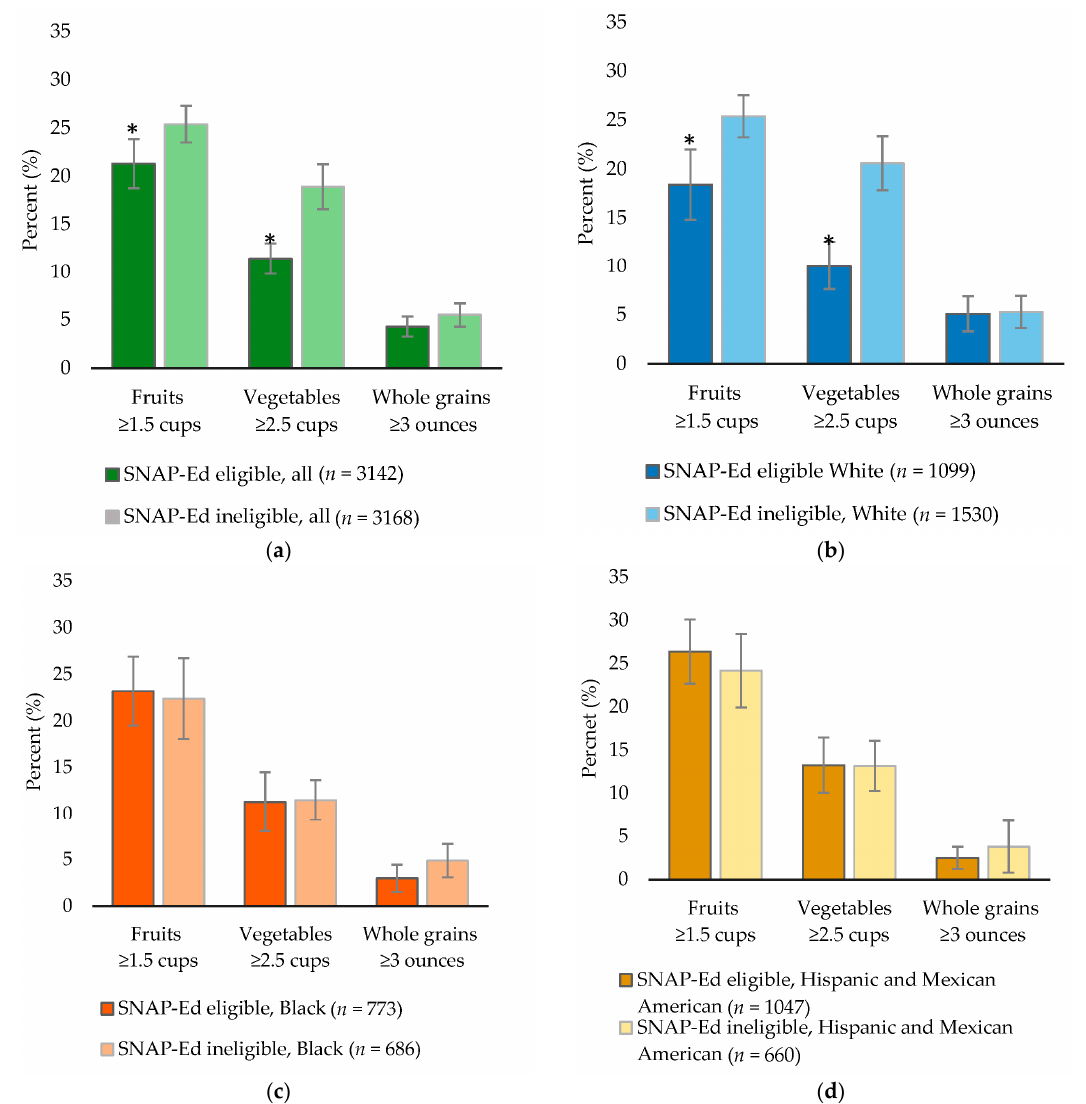
Figure 1. The percentage meeting the Dietary Guidelines for American recommendations of SNAP-Ed eligible and SNAP-Ed ineligible women nationwide, NHANES 2007–2012. ( a ) All ( b ) White ( c ) Black ( d ) Hispanic/Mexican American. Fruit and vegetable intakes are measured in cup equivalents and whole grain intake is measured in ounce equivalents. * Significantly different between SNAP-Ed eligible and SNAP-Ed ineligible women nationwide based on t -tests. Error bars indicate 95% confidence intervals. Table 2. The percentage meeting the Dietary Guidelines for American recommendations, overall and stratified by race/ethnicity and current SNAP participation status, among SNAP-Ed participating women in Indiana and SNAP-Ed eligible women nationwide, 2007–2012 1 .